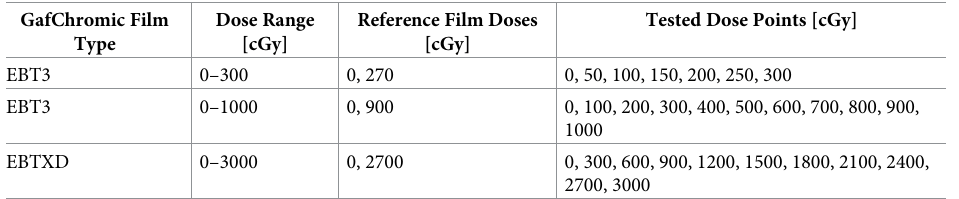
Table 1. Test film